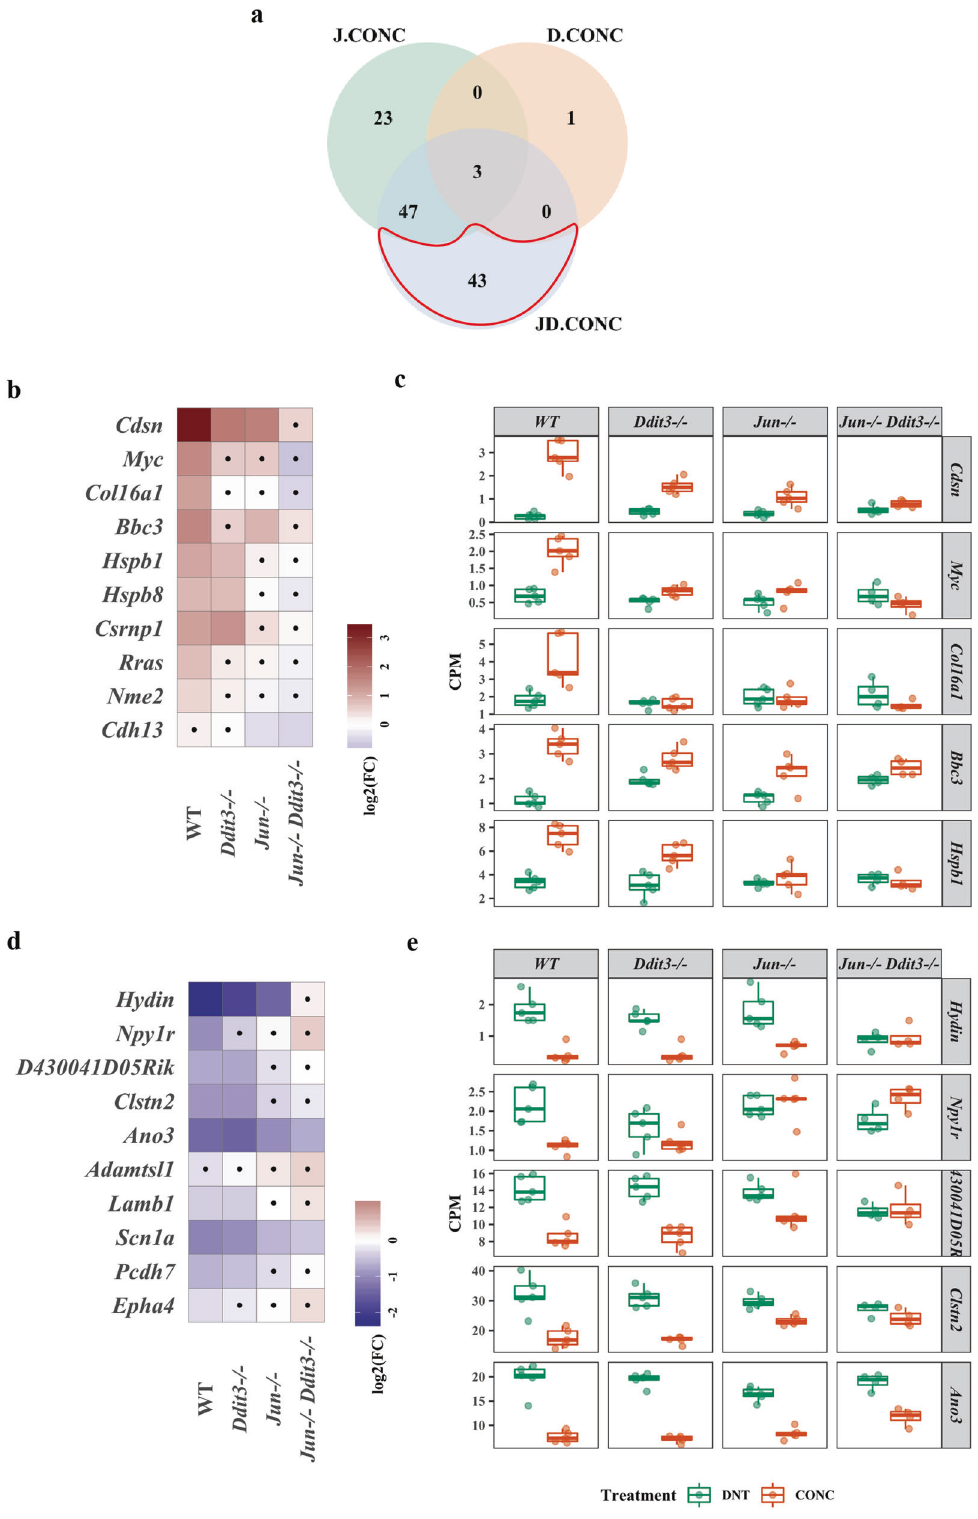
Fig. 4 DE gene analysis revealed CONC-responding genes affected by both Jun and Ddit3 . The Venn diagram shows the overlap of the DE genes as a result of interaction of CONC treatment and genotype, highlighting the CONC-responding genes affected by Jun and Ddit3 together ( a ). The fold change of top 10 CONC-responding genes activated ( b ) and inhibited ( d ) by Jun and Ddit3 together in all genotypes. Area marked with a dot indicates the fold change of a gene is not signi fi cant (FDR ≥ 0.05) in a given genotype group. Area without a dot indicates the fold change of a gene is signi fi cant (FDR < 0.05) in a given genotype group. Box plots demonstrate the expression levels of activated ( c ) and inhibited ( e ) genes in all genotypes after CONC (orange) as compared to unmanipulated retinas (DNT, green).